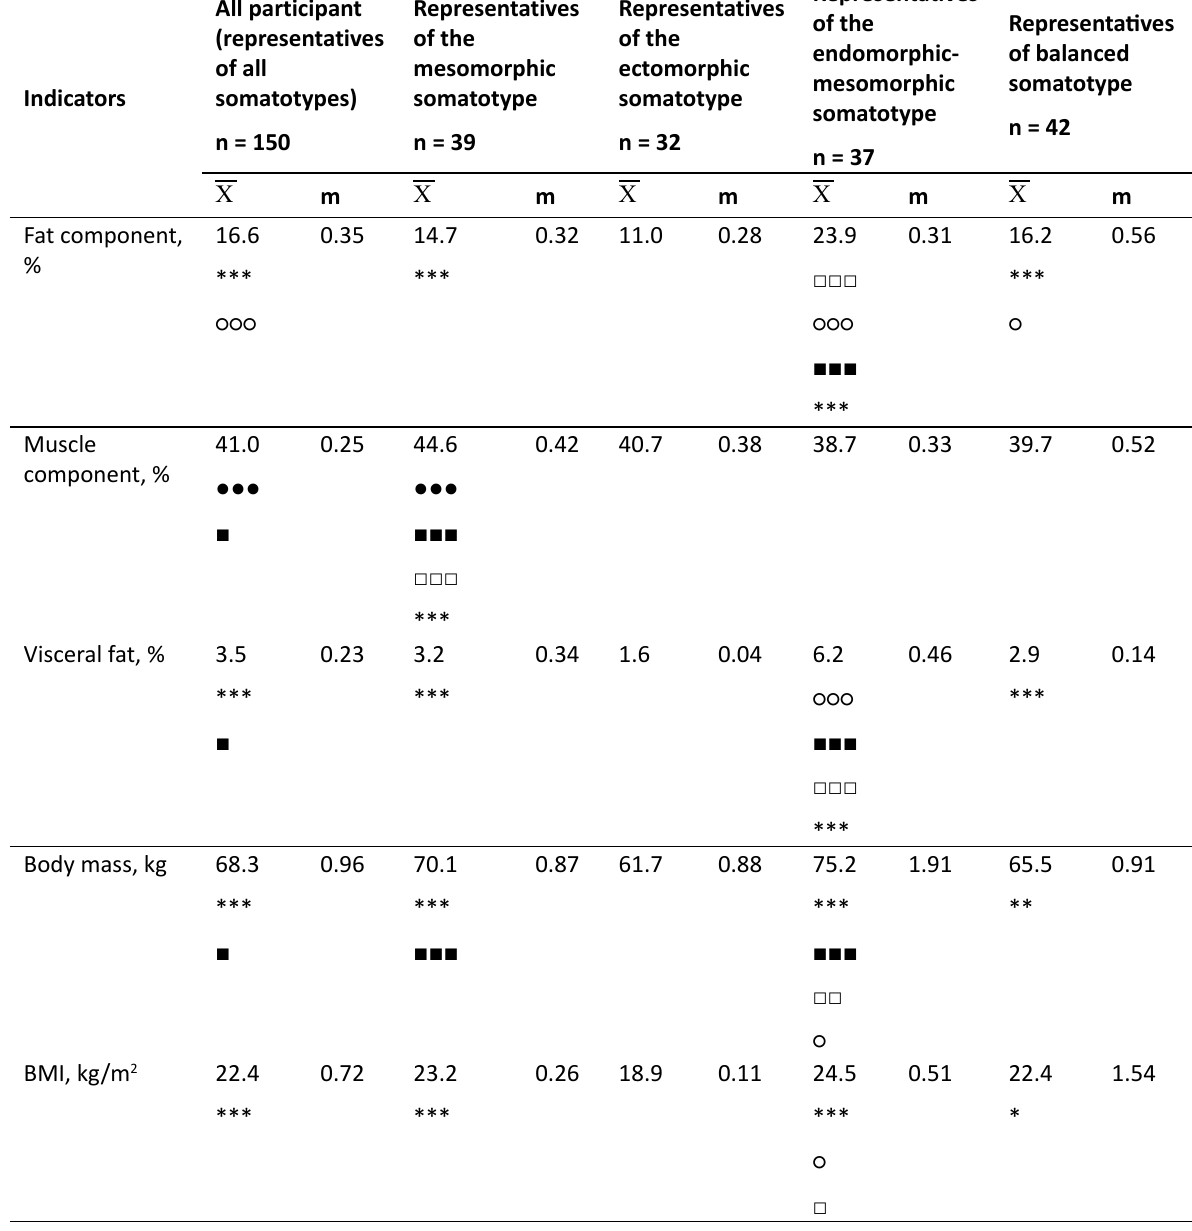
Table 2. Component body composition and body mass in men aged 25-35 with different somatotype All participant (representatives of all Indicators